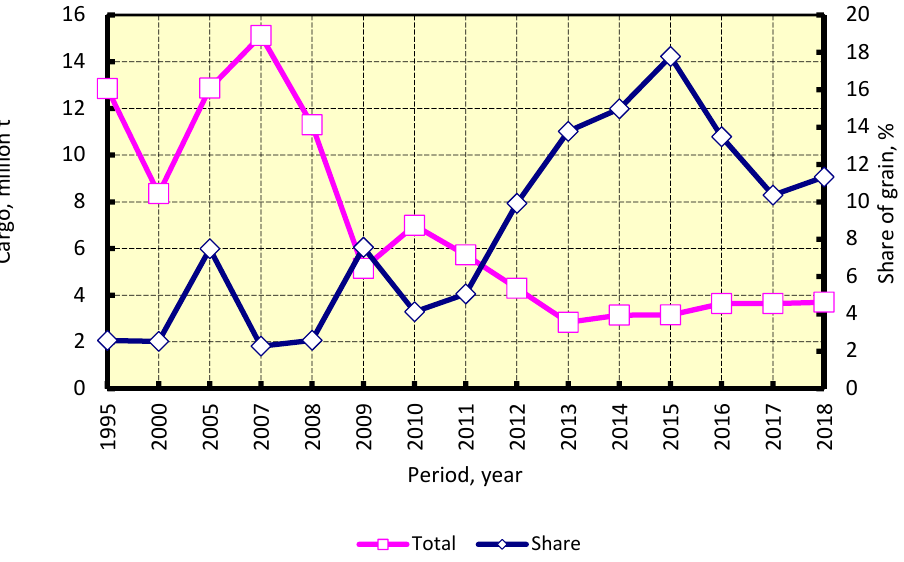
Figure 5. Cargo traffic by inland waterways transport in Ukraine.